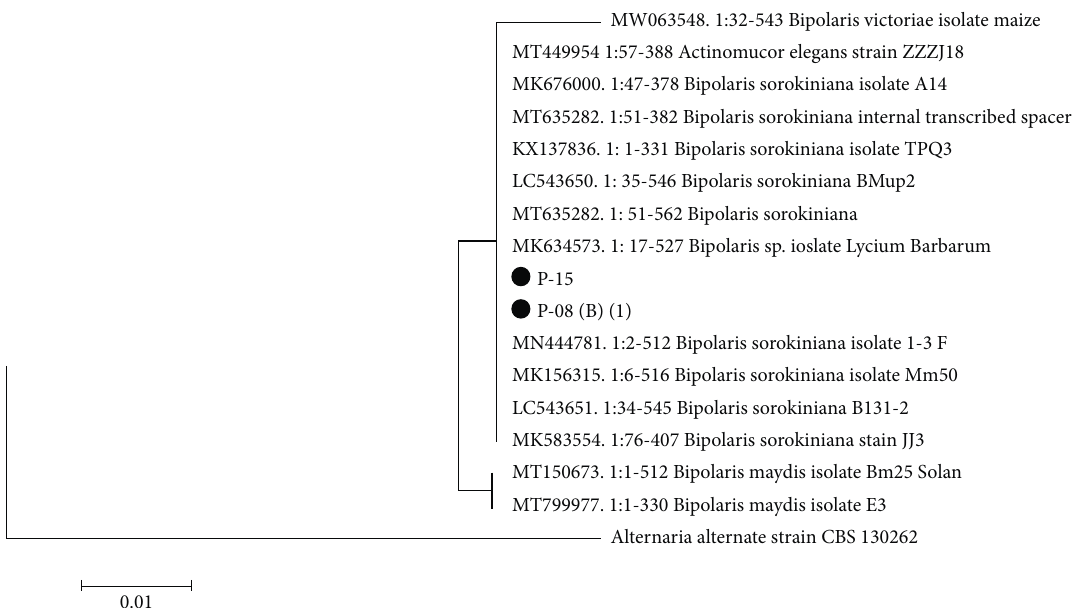
Figure 4: Phylogenetic tree for representative B. sorokiniana isolates.